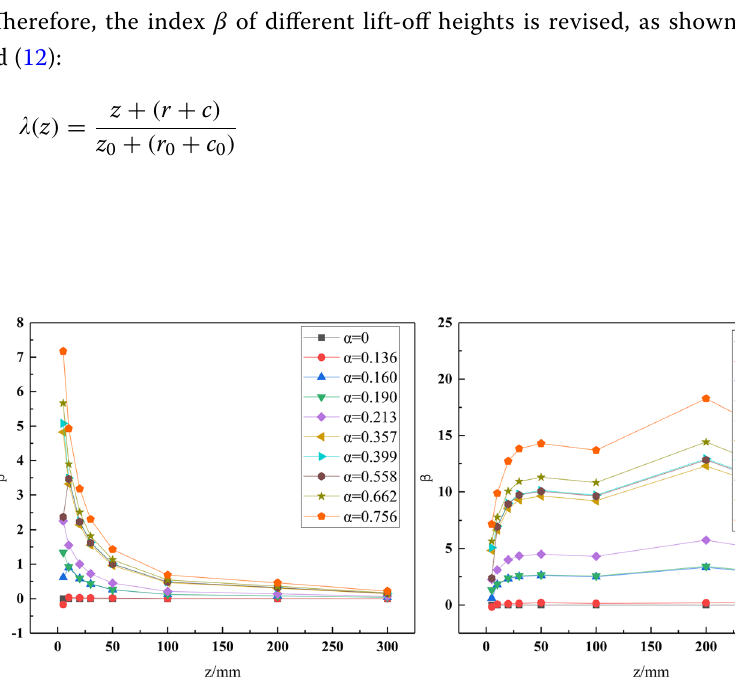
Fig. 11 The magnetic characteristic index β of the specimen under different lift-off heights. a β (not consider LFH). b β (consider